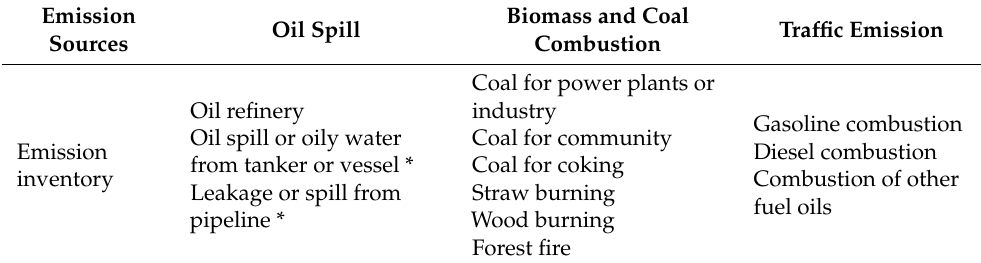
Table 1. Emission inventory for PAHs.